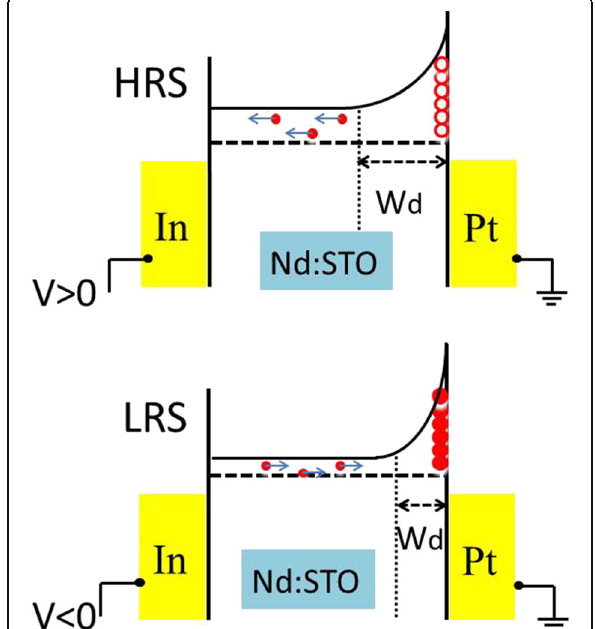
Fig. 5 Schematic diagram of energy band structure and interface state Pt/NSTO/In system at HRS and LRS. The red hollow and solid spheres at interface represent the unoccupied and occupied interface state,